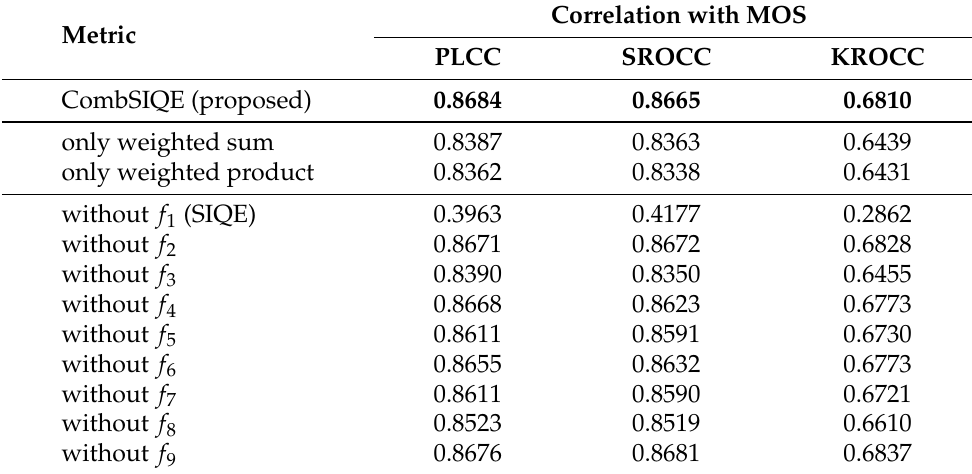
Table 2. The results of the ablation study—correlations with the subjective scores obtained for all 264 images from ISIQA database using the proposed combined metric and its simplified versions. The results of the proposed metrics are presented in